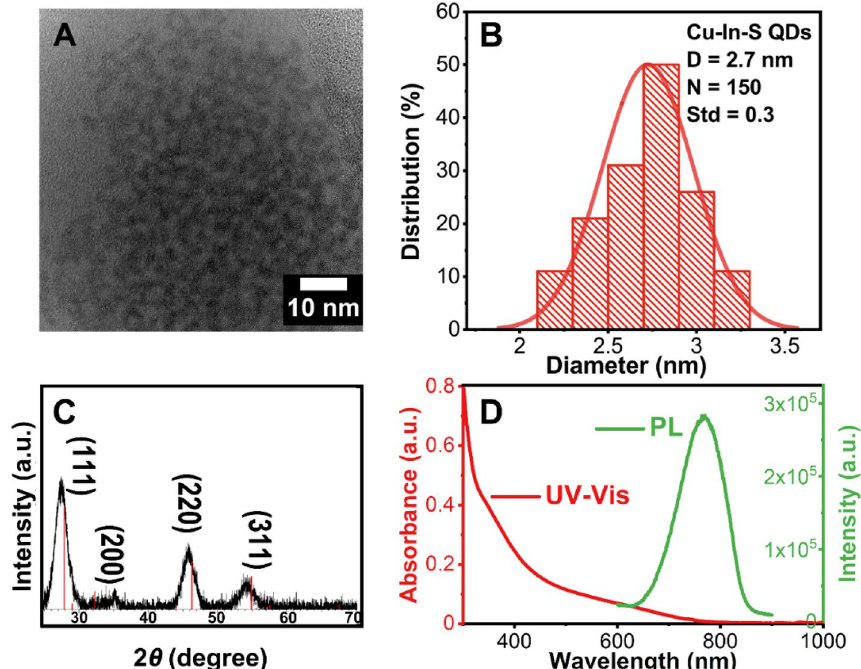
Figure 1. ( A ) TEM image, ( B ) Diameter distribution histogram, ( C ) XRD diffraction pattern (The red lines indicate the reference PDF 65-2732 CuInS 2 ) and ( D ) UV–Vis spectrum (red line) and PL spectrum (green line) of the obtained Cu–In–S